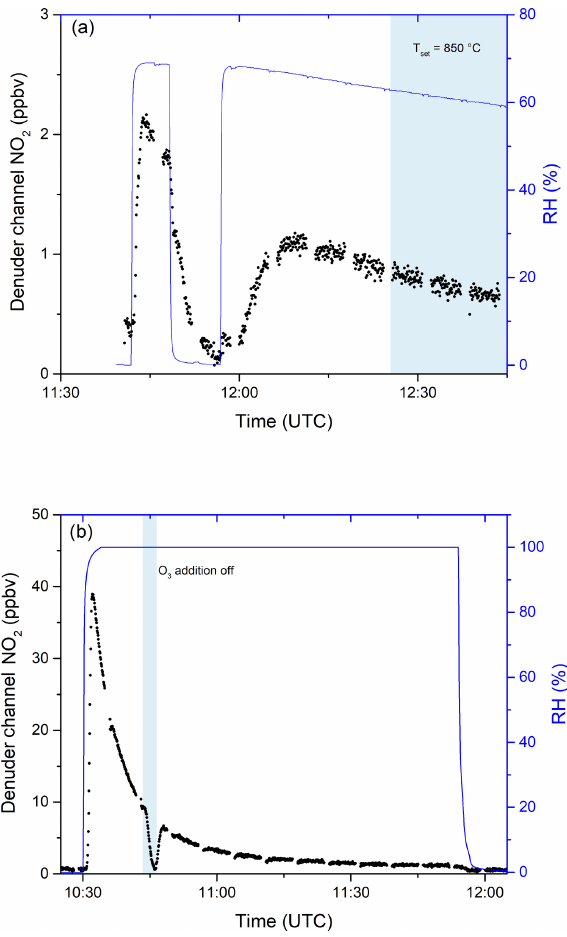
Figure 7. (a) Release of NO x from the denuder in humid air after exposure to 9.5ppmv iPN for 1.5h. Relative humidity was mea- sured before passing through the denuder. The blue shaded area signifies the period in which the inlet oven was heated to 850 ◦ C. Changes in RH are achieved by flowing parts of the zero air stream through deionised water. (b) The release of NO x from the denuder in humid air after exposure to 0.83ppmv NO 2 for 4.8d. O 3 addition was switched off during the blue shaded